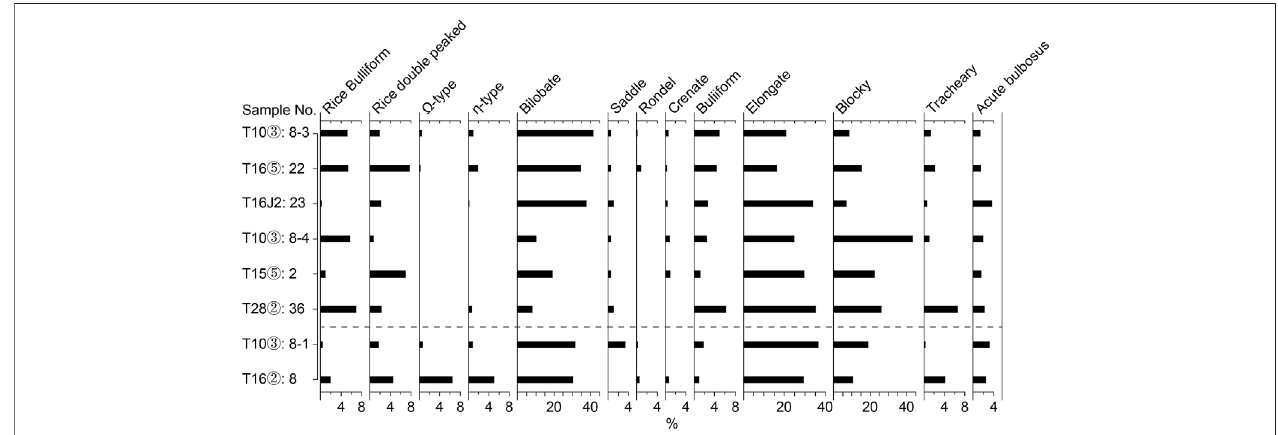
FIGURE 5 | Percentage of each type of phytolith recovered from the residues on the grooved pottery vessels at the Meishan site. The samples above the dashed line are from the late Longshan period, while the samples below the dashed line are from the Erlitou period.